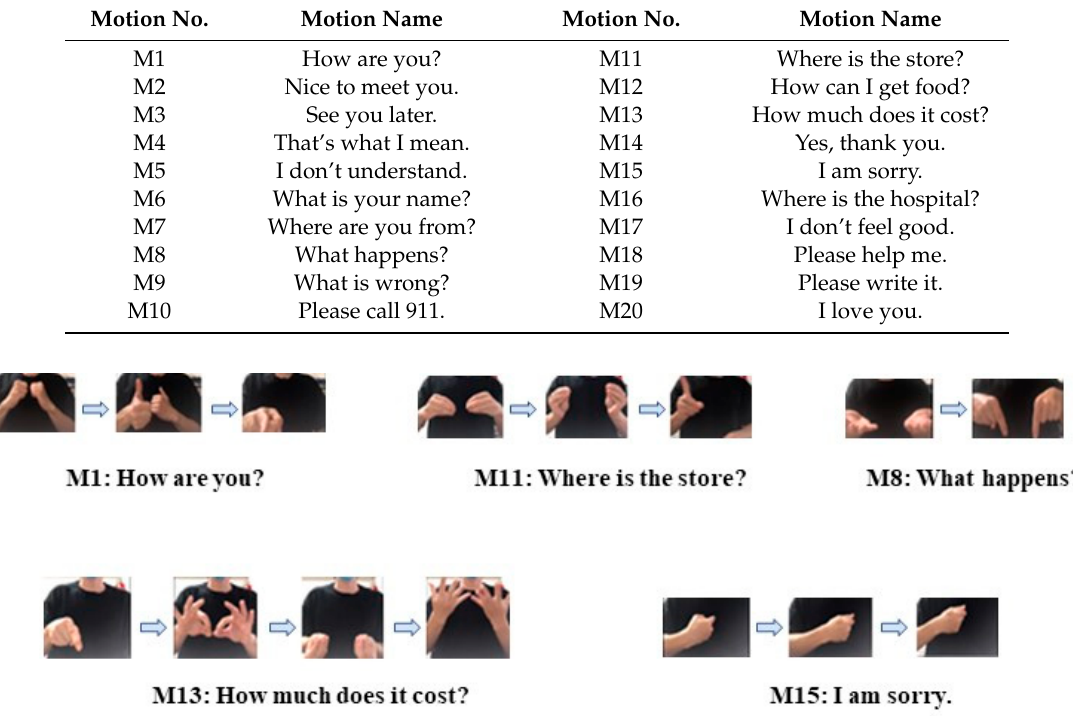
Table 1. The 20 hand motions.